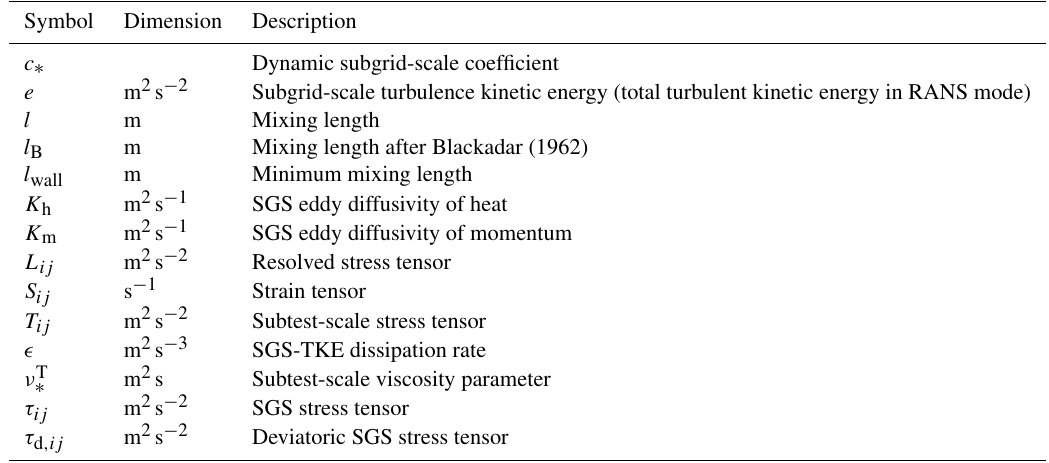
Table 3. List of SGS model symbols. Symbol Dimension